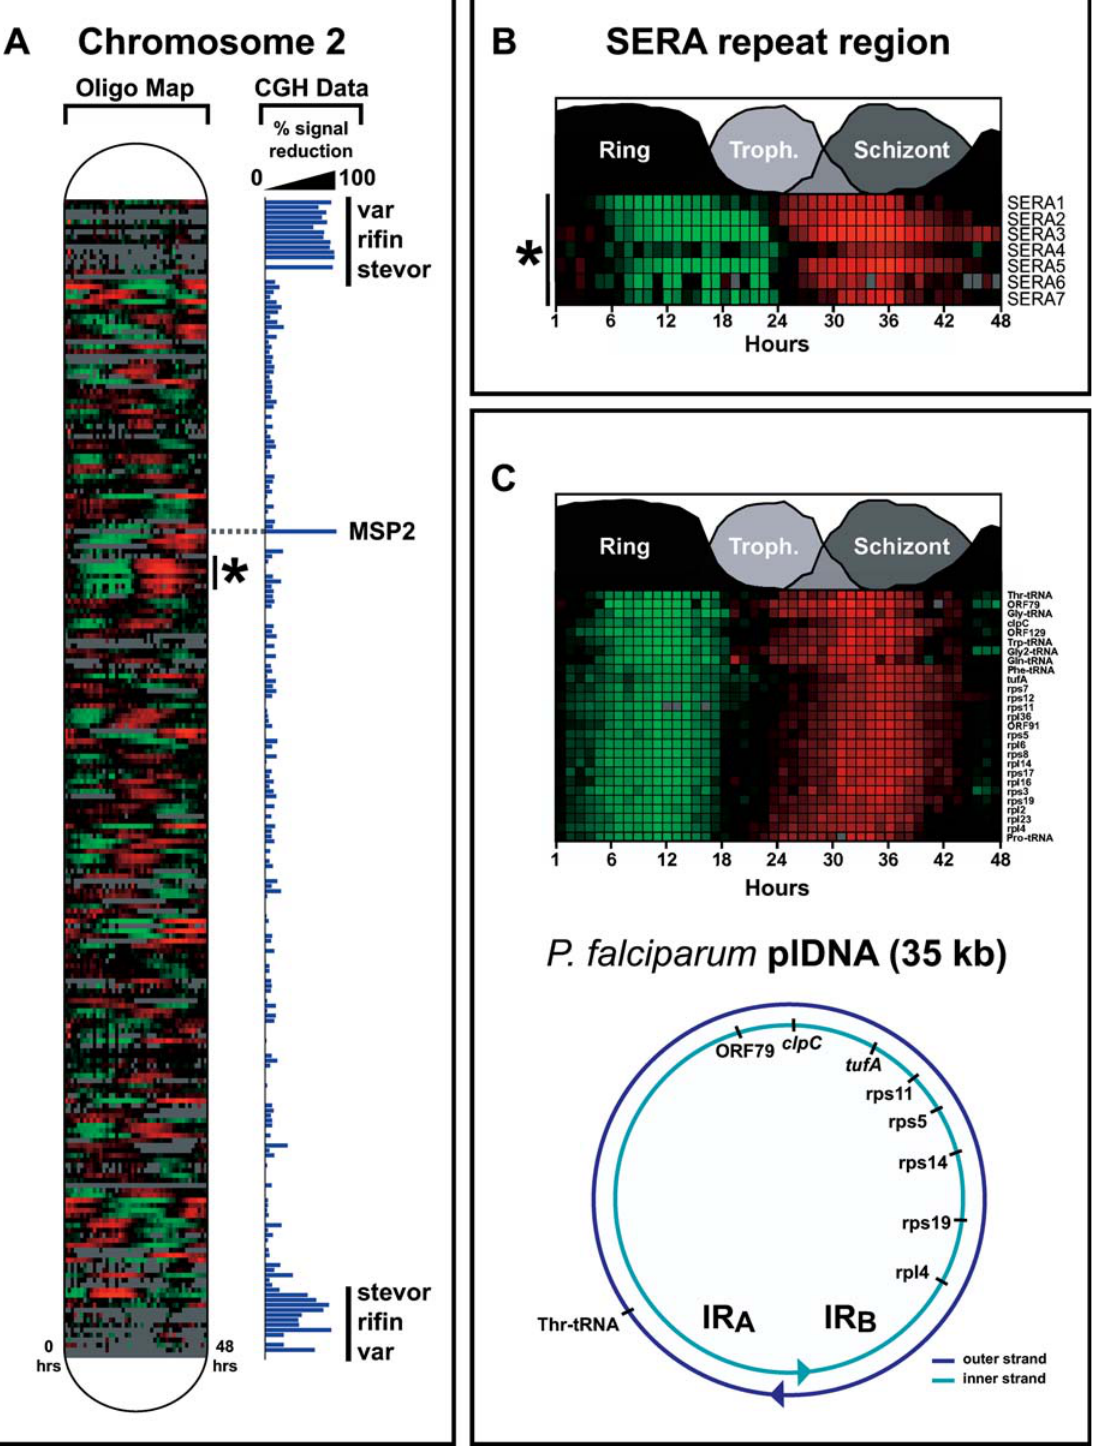
Figure 3. Coregulation of Gene Expression along the Chromosomes of P. falciparum Is Rare, While Plastid Gene Expression Is Highly Coordinated Expression profiles for oligonucleotides are shown as a function of location for Chromosome 2 ([A], Oligo Map). With the exception of the SERA locus (B), coregulated clusters of adjacent ORFs are seldom observed, indicating that expression phase is largely independent of chromosomal position. (C) In contrast to the nuclear chromosomes, the polycistronic expression of the circular plastid genome is reflected in the tight coregulation of gene expression. This is an expanded view of the plastid-encoded genes from Figure 2J. Genomic differences between strain 3D7, from which the complete genome was sequenced, and strain HB3 were measured by CGH. The relative hybridization between the gDNA derived from these two strains is shown as a percent reduction of the signal intensity for 3D7 ([A], CGH Data). Differences between the two strains are predominately located in the subtelomeric regions that contain the highly polymorphic var, rifin, and stevor gene families. Intrachromosomal variations, as observed for the msp2 gene, were rare. DOI: 10.1371/journal.pbio.0000005.g003 PLoS Biology | http://biology.plosjournals.org Volume 1 | Issue 1 | Page